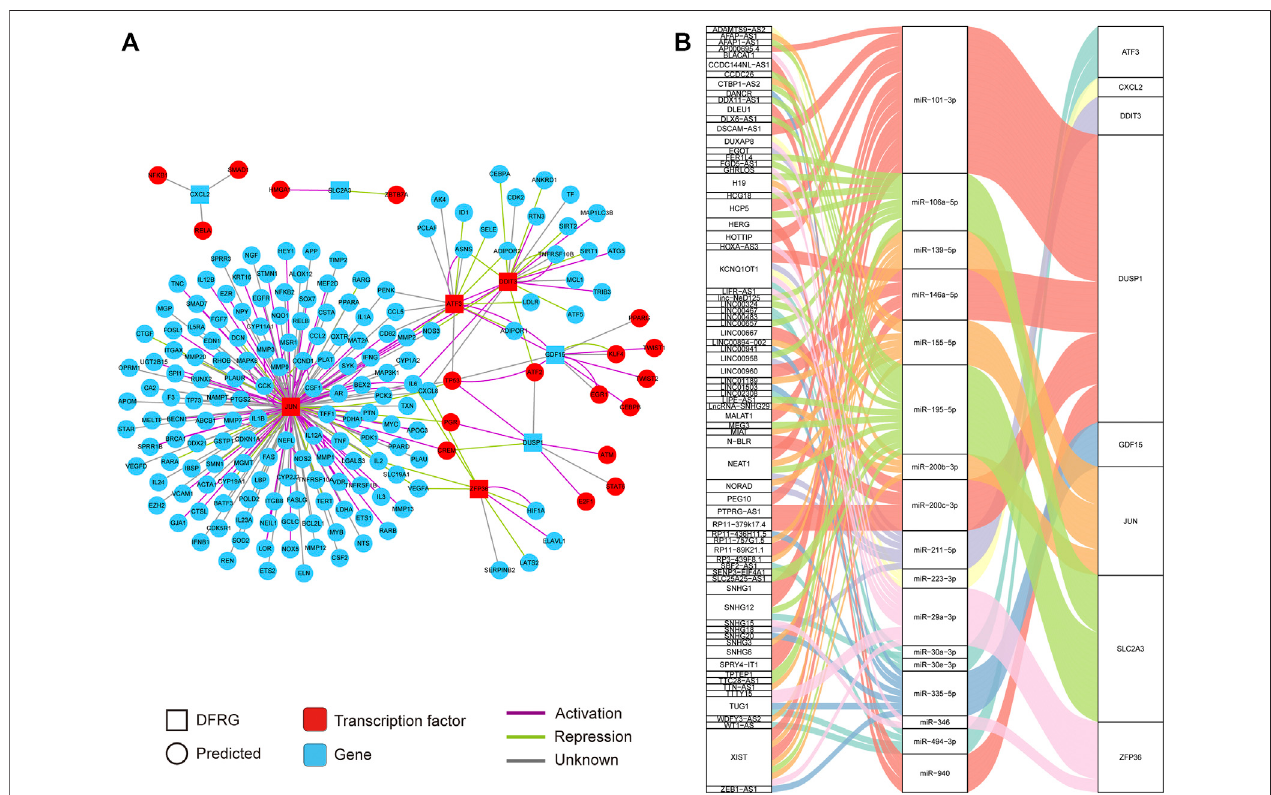
FIGURE 3 | Construction of the transcription factor regulatory network and the lncRNA – miRNA – mRNA network based on eight DFRGs. (A) Transcription factor regulatory network of DFRGs constructed by using data from the TRRUST database. The interaction between transcription factors and targets were shown in green (repression) or purple lines (activation). (B) Construction of the lncRNA – miRNA – mRNA network with data from miRtarBase and LncACTdb databases.